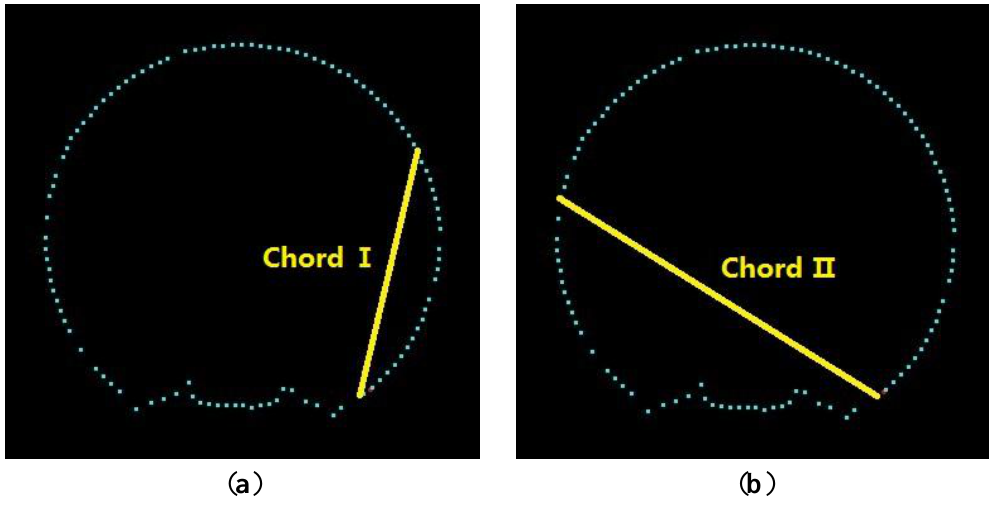
Figure 18. Chords used for comparison. ( a ) Chord I; ( b ) Chord II.